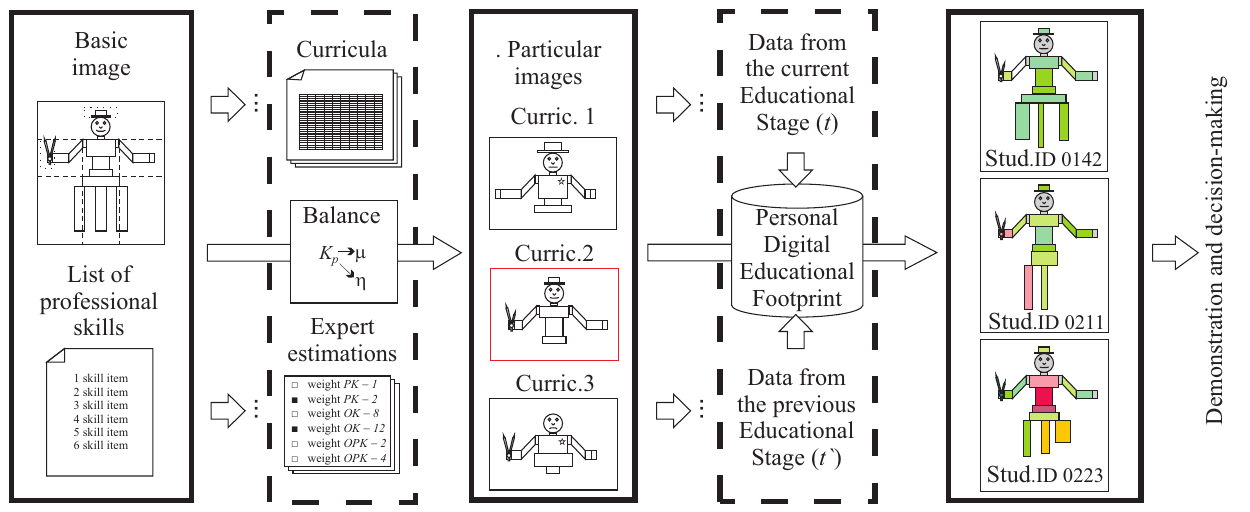
Figure 7. Stages of creating images in the UGVA notation for assessment and monitoring of students’